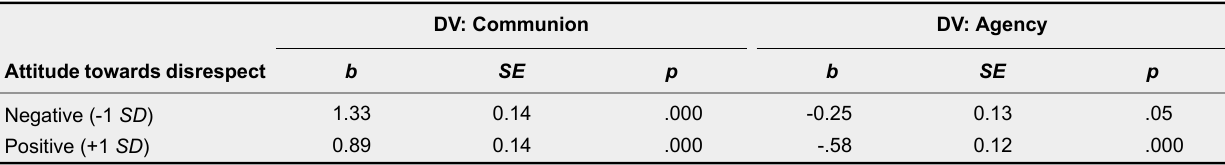
Simple Slope Analysis of the Interaction Effect of Disrespectful vs. Respectful Candidate Behavior a and Voters’ Attitude Towards Disrespect in Politics on the Two Dimensions of Social Judgment in Study 1